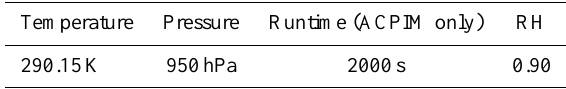
Table 1. Initial conditions for the